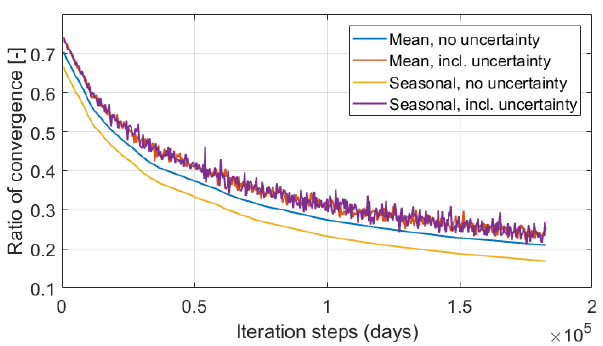
Figure B2. Convergence test in the Mataura catchment, Southland, New Zealand, with inclusion of uncertainty and a Gaussian distribution over the year to include seasonality of